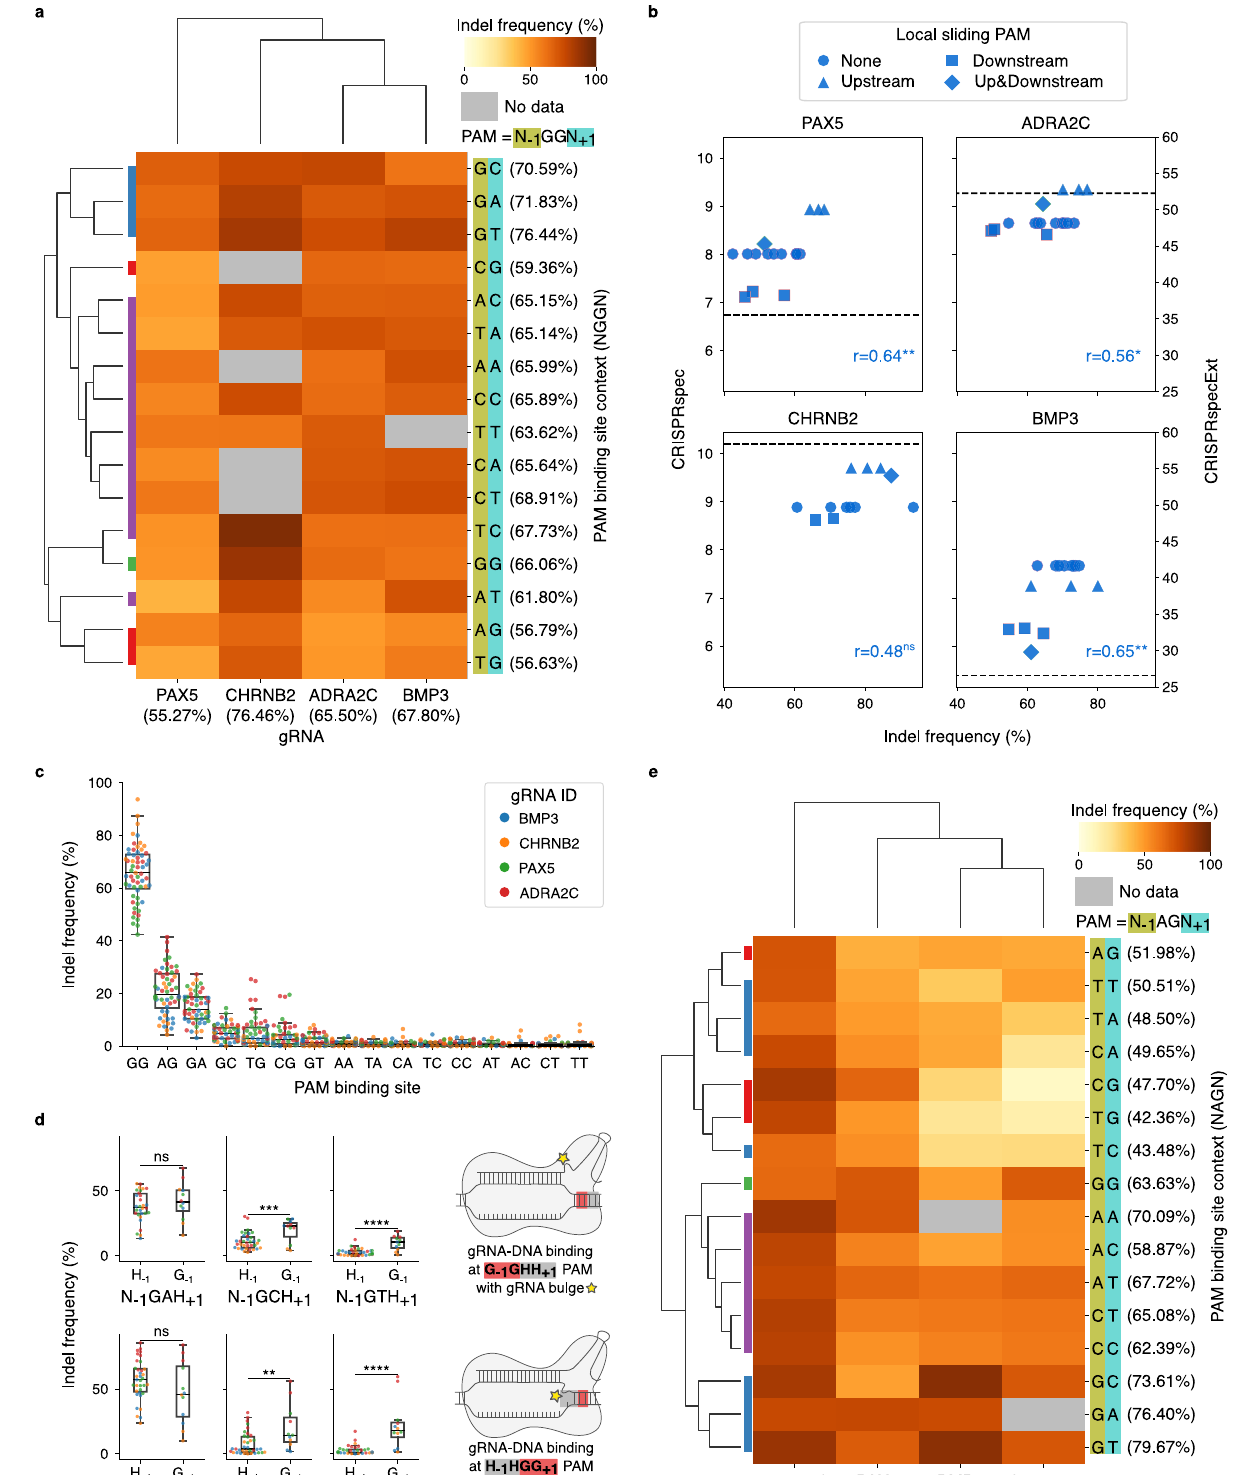
The ef fi ciencies related to target sites with G − 1 AGH + 1 PAMs in Dox + cells are signi fi cantly more ef fi cient (mean increase 33.45%) compared to H − 1 AGH + 1 PAMs (Fig. 4e, Supplementary Fig. 14). This trend is similar to the one observed for the canonical G − 1 GGH + 1 PAM in Dox − . G − 1 generates a non-canonical GA binding site, less stable than GG or AG. This could